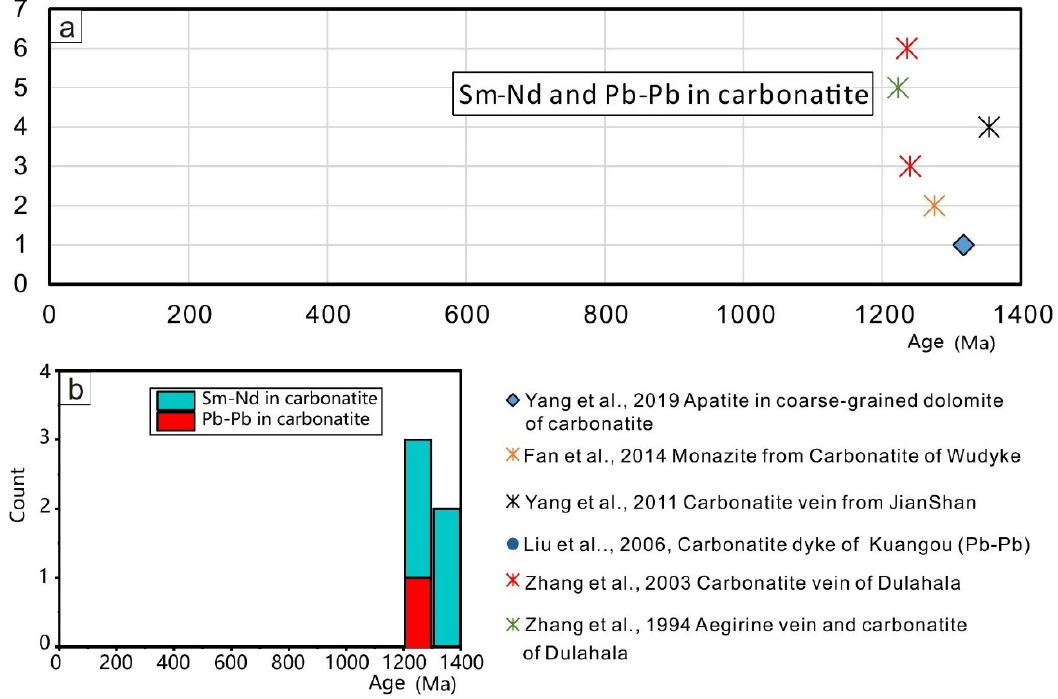
Figure 13. Age distribution characteristics of Sm–Nd and Pb–Pb in slate. ( a ) Single age distribution characteristics corresponding to different studies. ( b ) Stack histograms of all ages. [1,3,34,42,44].